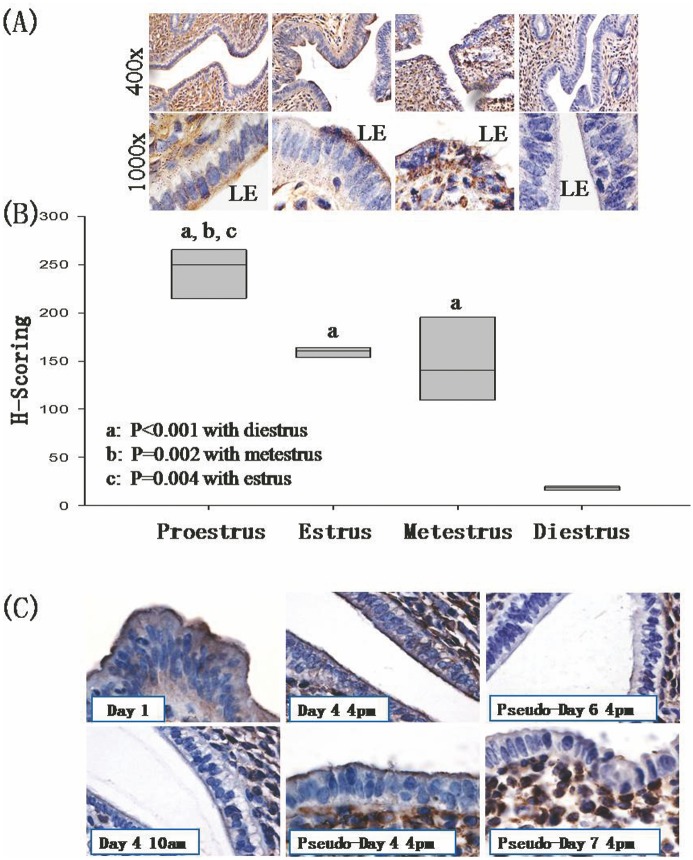
Axna2 expression in mouse endometrial luminal epithelium.
(A) Endometrial Axna2 expression in the estrous cycle: Axna2 expression was high in the luminal epithelium (LE) at proestrous, and absent at diestrous. (B) H-Scoring of the immunostaining. a P<0.001 with diestrus, b P = 0.002 with metestrus. c P = 0.004 with estrus. (C) Axna2 expression in mouse LE in early pregnancy. Axna2 expression was increased after estradiol surge (10:00 am—12 noon) on Day 4 of pregnancy, and was decreased on Day 6 and Day 7 of pregnancy. Magnification: 1000x.